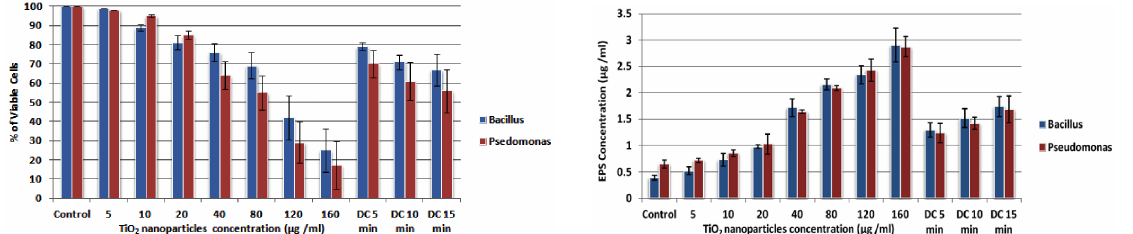
Figure 6: The effect of TiO 2 -NP concentrations (5-160 µ g/mL) and DC exposure (5, 10, and 15 min) on the percentage of viable cells of B. cereus and P. aeruginosa biofilms.